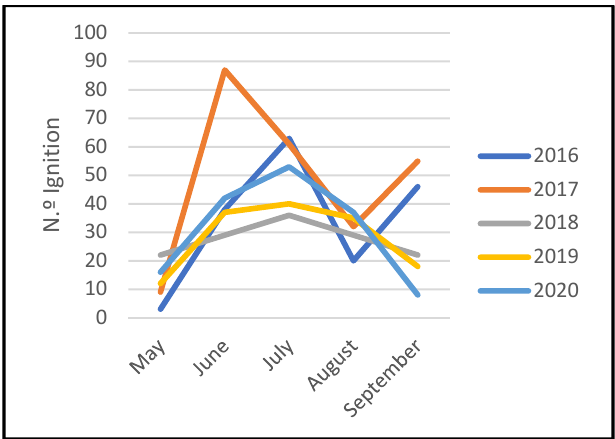
Figure 4. The number of monthly critical season ignitions for the years 2016–2020.